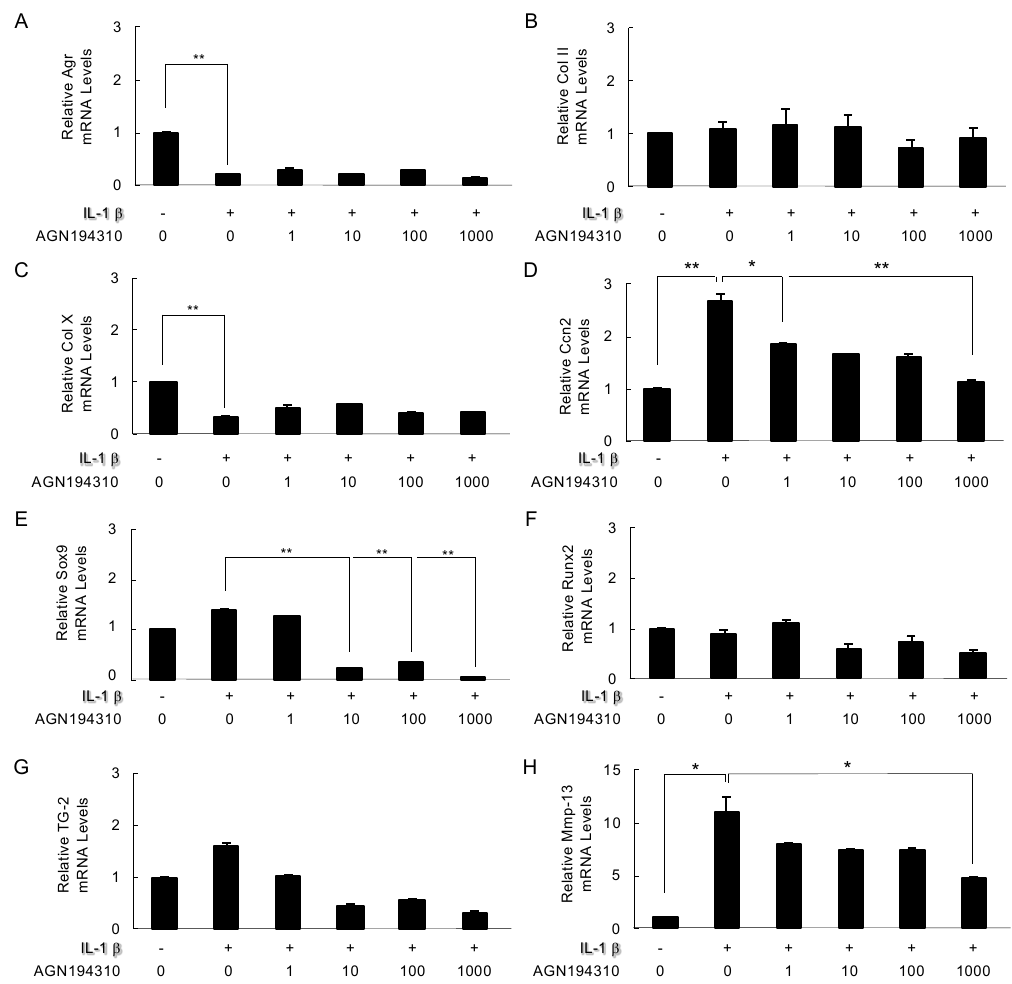
Figure 3. The e ff ect of the RAR inverse agonist AGN194310 on IL-1 β modulated genes. ATDC5 cells were exposed to 10 ng / mL IL-1 β with the indicated amount of the RAR inverse agonist AGN194310 for 24 h. Total RNA from these cells was used in a real-time RT-PCR for the analysis of the mRNA expressions of Agr ( A ), Col II ( B ), Col10 ( C ), Ccn2 ( D ), Sox9 ( E ), Runx2 ( F ), Tg2 ( G ), and Mmp13 ( H ). The values in the graph indicate the relative mRNA level of the fold changes. Columns and S.D. bars, mean of triplicate determinations. Statistically significant di ff erences (* p < 0.05, ** p < 0.01) between the indicated groups are marked by